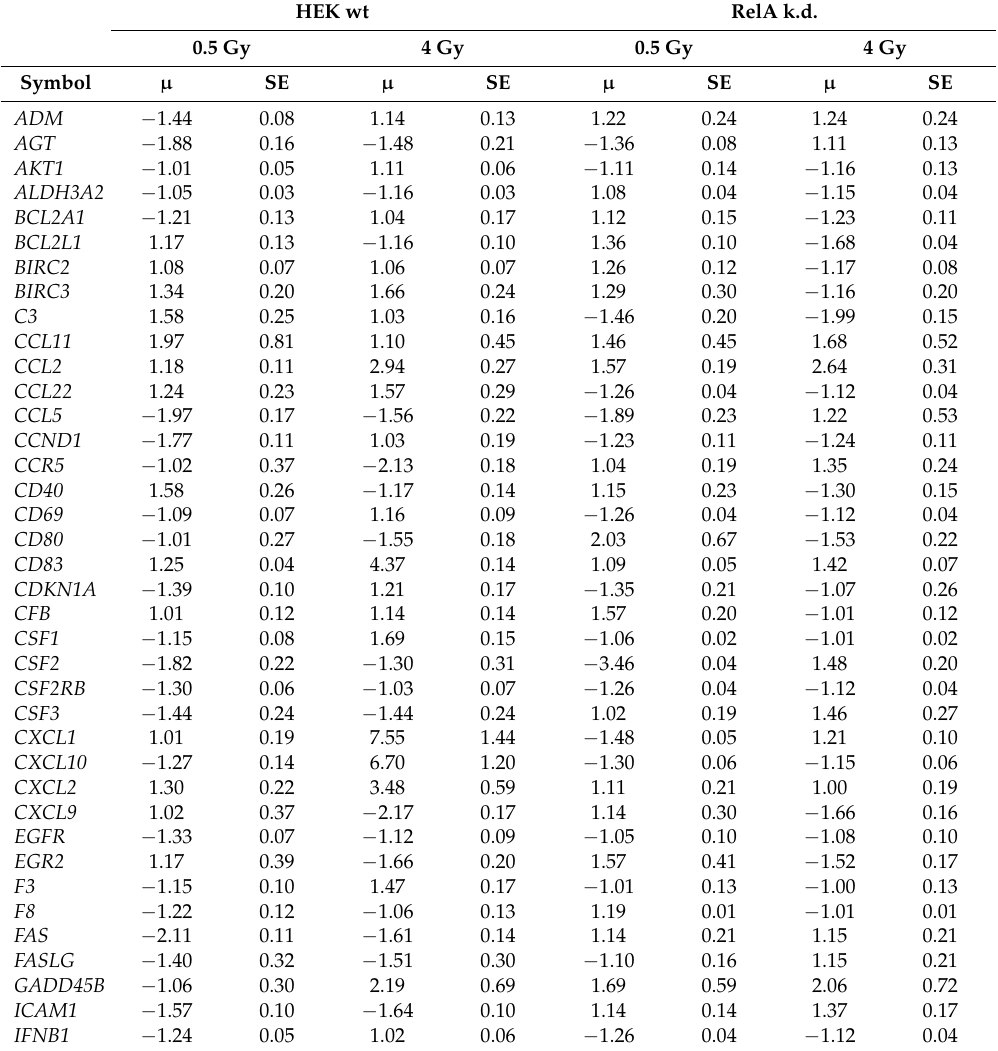
Table A6. Relative gene expression in HEK-pNF- κ B-d2EGFP/Neo L2 (HEK wt) and HEK shRNA RelA (RelA k.d.) cells after irradiation using the RT2 Profiler PCR array: Ti